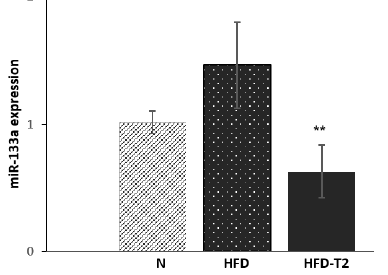
Figure 6. qPCR analysis of miR-133a in sWAT of N, HFD, and HFD-T 2 rats. Values are means ± SEM of five independent experiments ( N = 5), ** p < 0.05 vs. N-HFD.